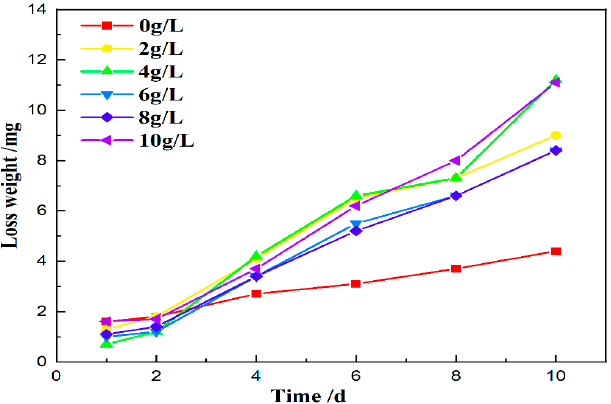
Figure 6. Hydrochloric acid immersion weight loss curves of MAO coating with the addition of various concentrations of CuSO 4 .